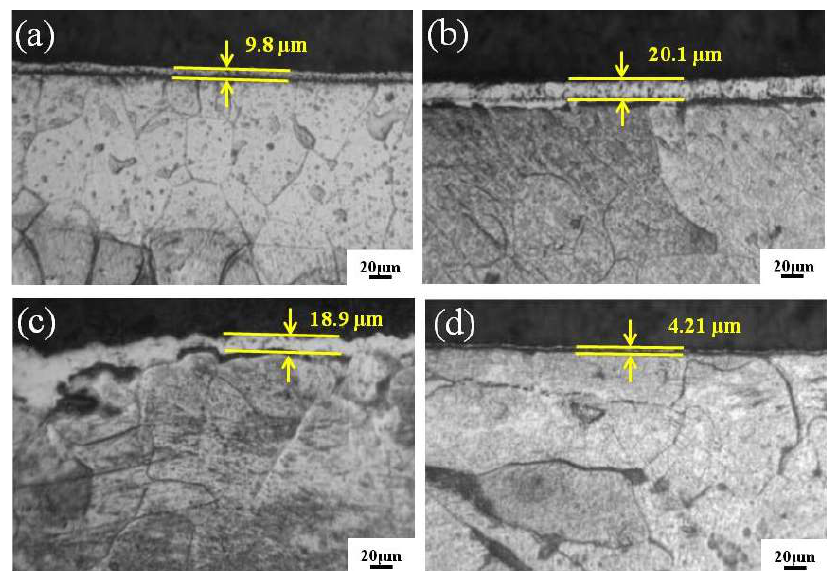
Figure 3. The cross-sectional metallographic microscope (MM) images of Fe-Al-Cr alloyed layers under different sample temperatures: ( a ) 750 °C; ( b ) 800 °C; ( c ) 850 °C; ( d ) 900 °C.